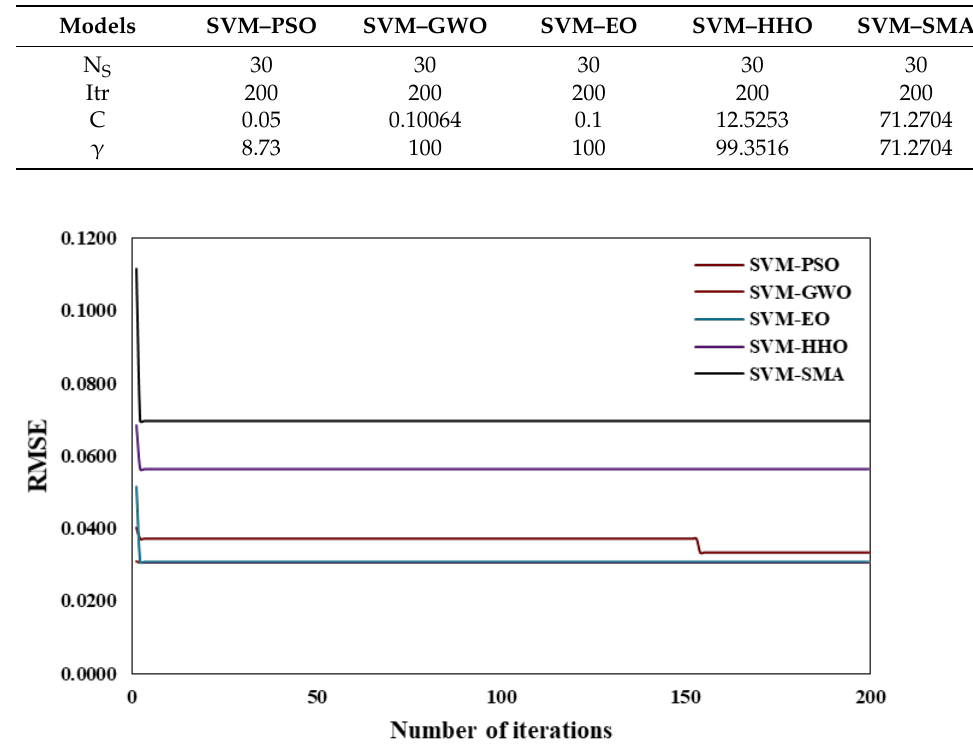
Table 3. Parametric configuration of hybrid SVM models.